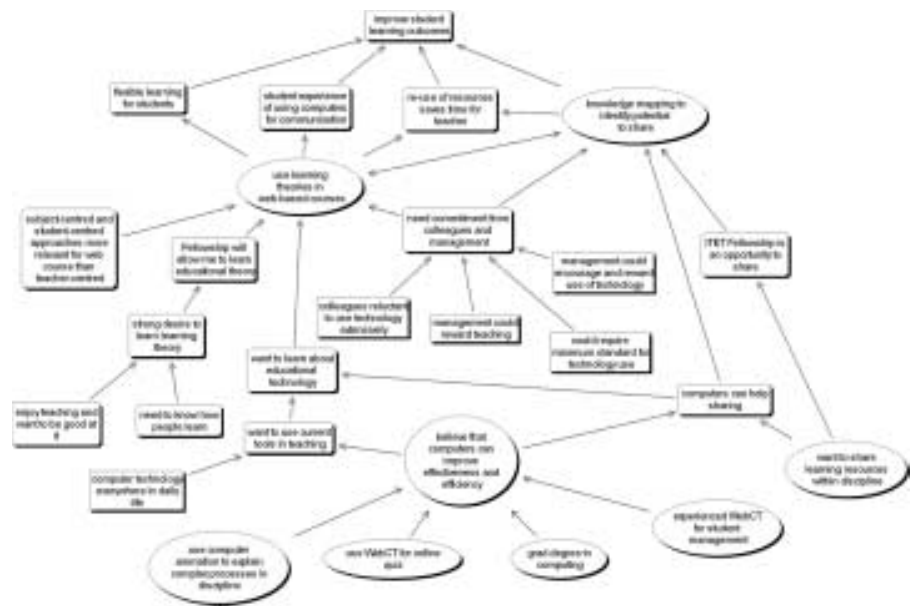
Figure 2. A cognitive map of a strategy for adopting e-learning (shapes indicate concept categories). Results and interpretation Patterns found in cognitive maps